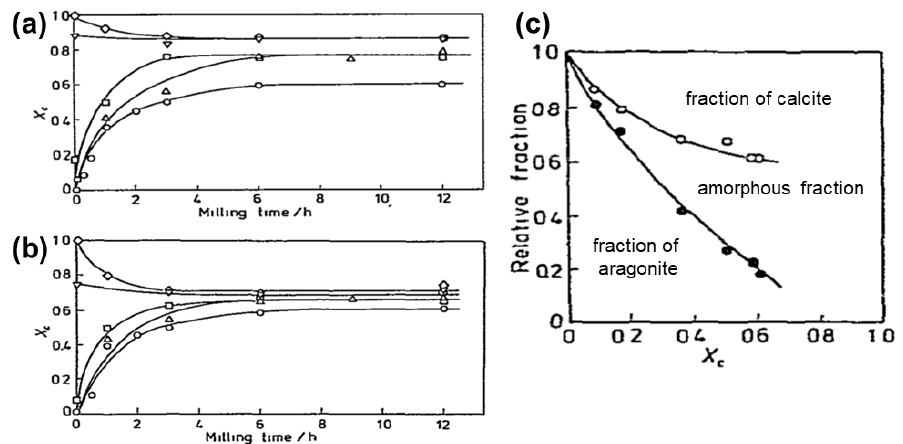
Figure 12. Mechanochemical equilibration of calcite and aragonite, studied by Iguchi and Senna: ( a ) change in calcite content for different milled samples based on PXRD analysis and ( b ) based on infrared spectroscopy analysis. Different symbols are used to distinguish data collected for samples annealed at different temperatures (between 473 and 773 K). ( c ) Change in the relative contents of calcite, aragonite, and amorphous CaCO 3 phases with respect to fraction of calcite [202]. Fractions of calcite and aragonite are designated by open and full circles, respectively.